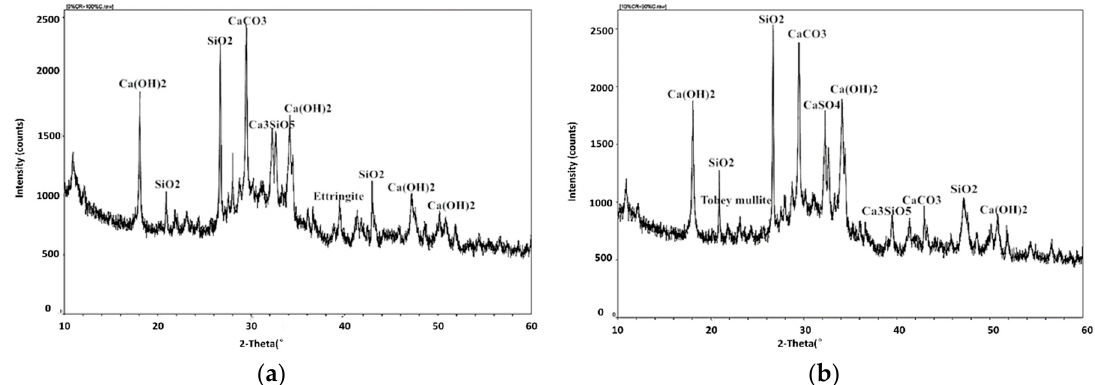
Figure 11. XRD maps of different concrete specimens at 28 days: ( a ) Ordinary cement; ( b ) 10% coke residue, and 90% cement.